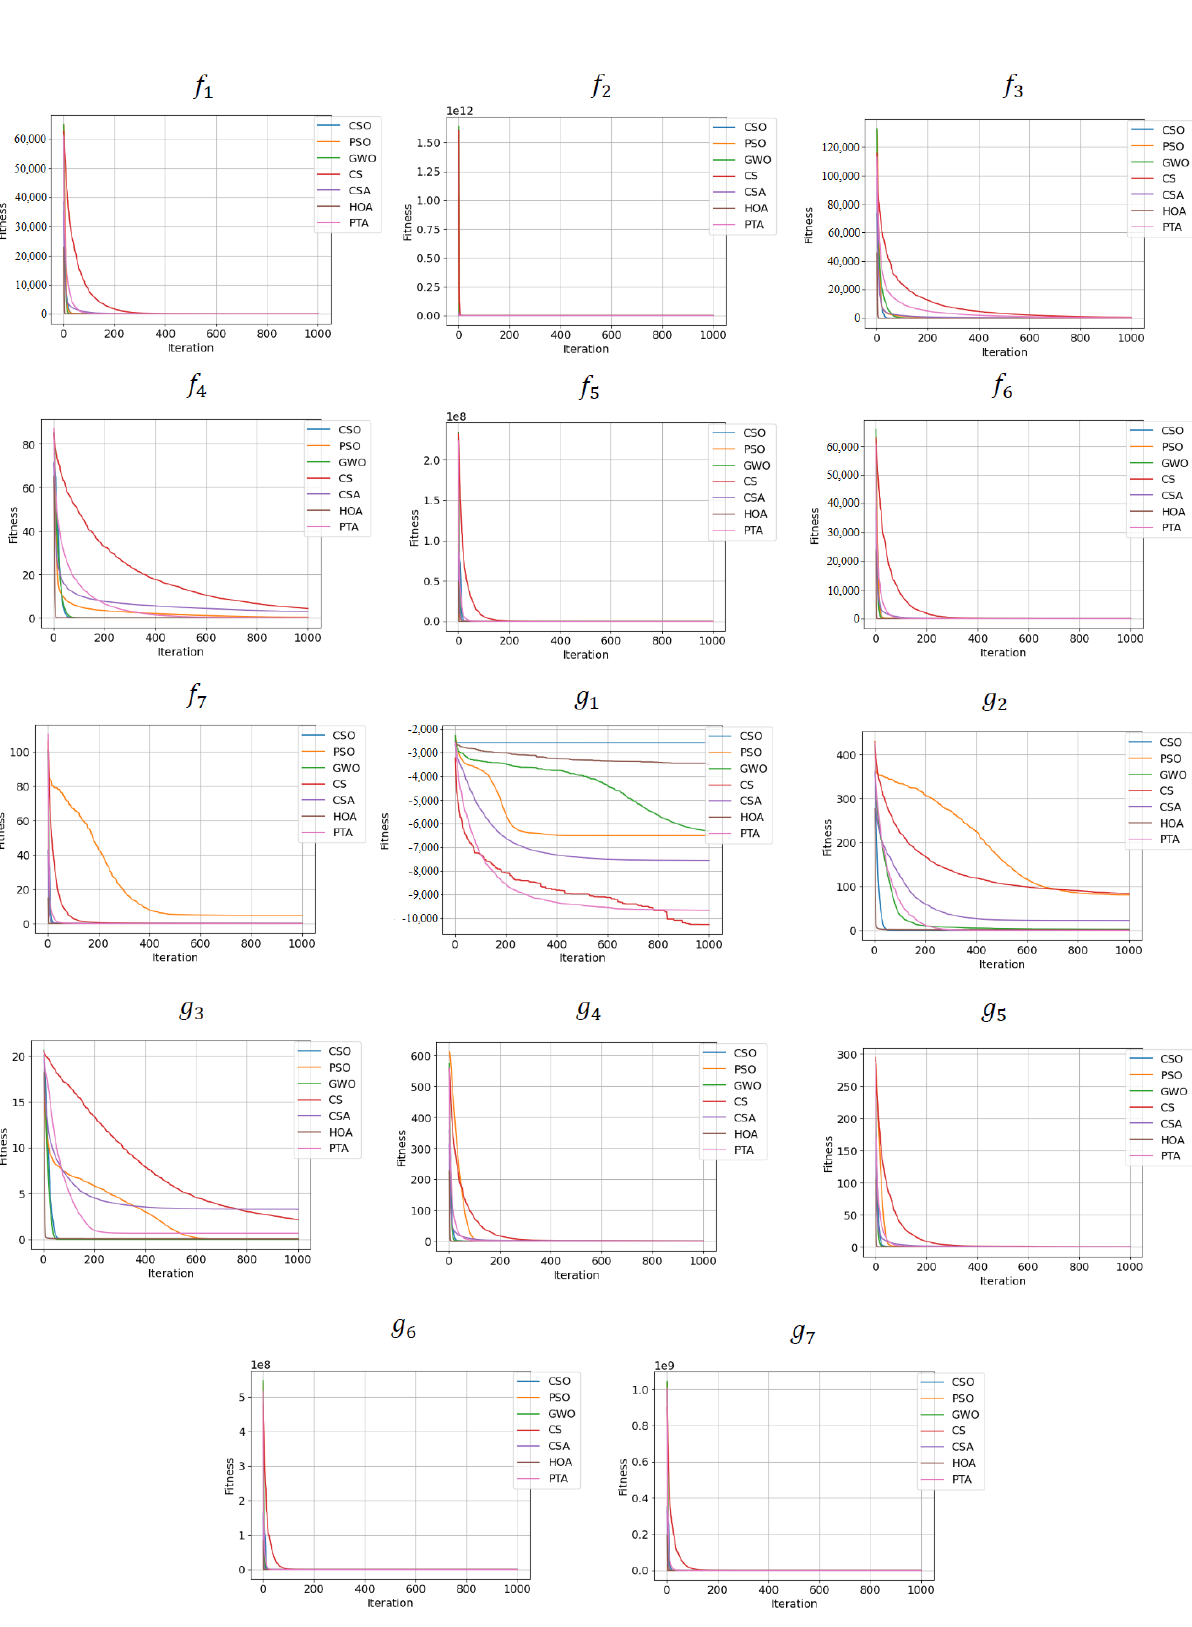
Figure 6. Convergence Charts for the Objective Functions 𝑓 1 − 𝑓 7 and 𝑔 1 − 𝑔 7 .